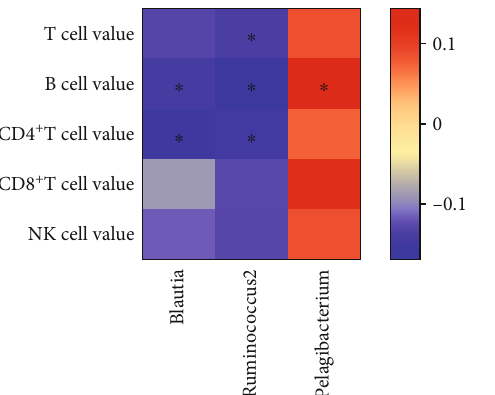
Figure 5: A heat map shows the correlation between di ff erent gut microbial species and lymphocyte subpopulations. Colors indicate the Spearman rank correlation ( ∗ P < 0 : 05 ).